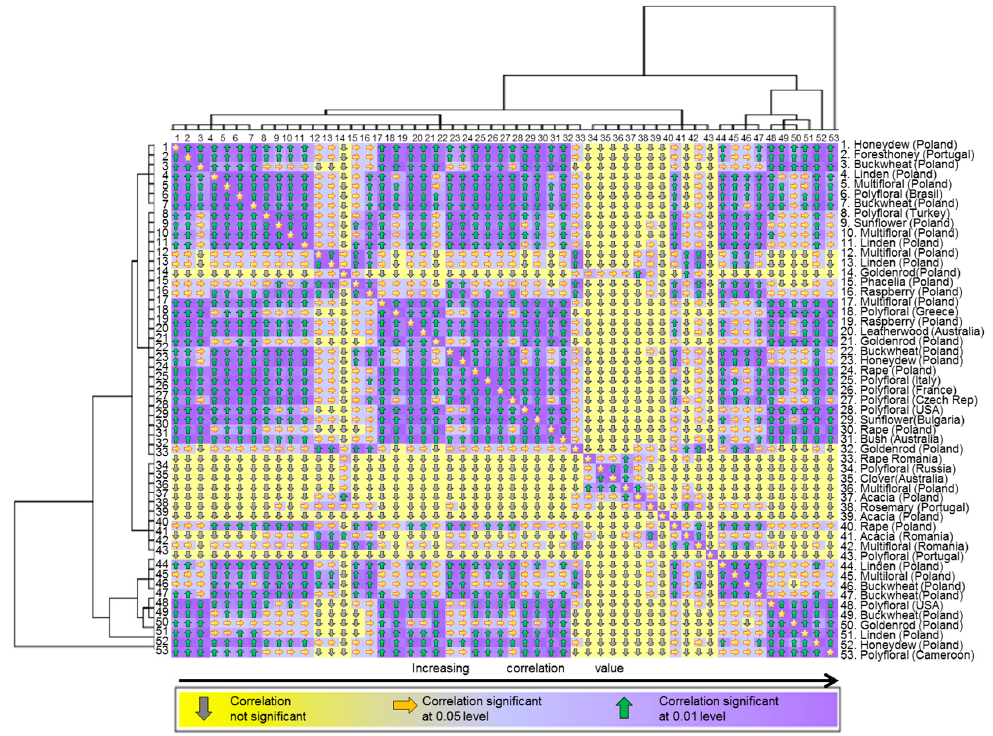
Figure 3. Heat map presenting the correlation between the 53 investigated honey samples.